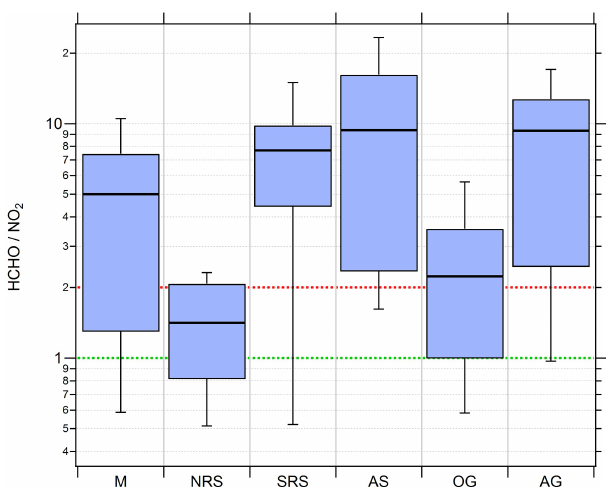
Figure 10. Box and whiskers plots of the HCHO / NO 2 ratio for the different regions with the black bar indicating the median value. Red (ratio of 2) and green (ratio of 1) lines indicate the limits for HCHO / NO 2 deduced by Duncan et al. (2010) for NO x limitation and VOC limitation,